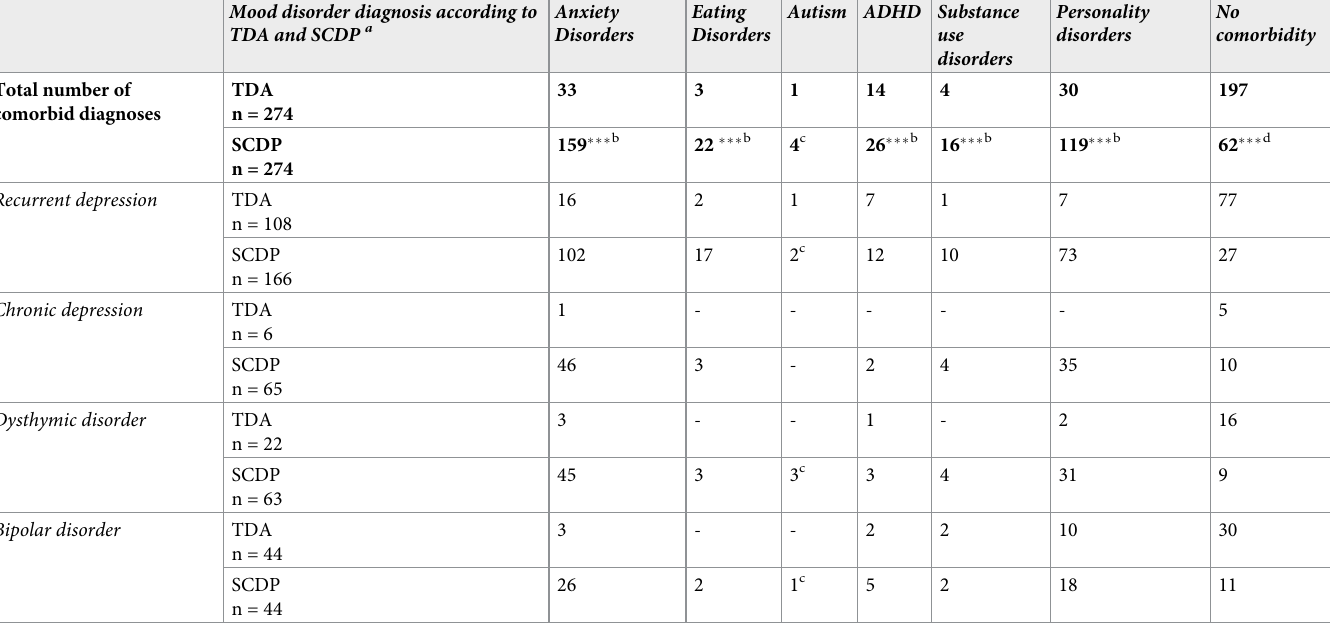
Table 3. Psychiatric comorbidity compared for traditional diagnostic assessment (TDA) according to medical records and structured and comprehensive diagnos- tic procedure (SCDP) according to the study protocol. Mood disorder diagnosis according to TDA and SCDP